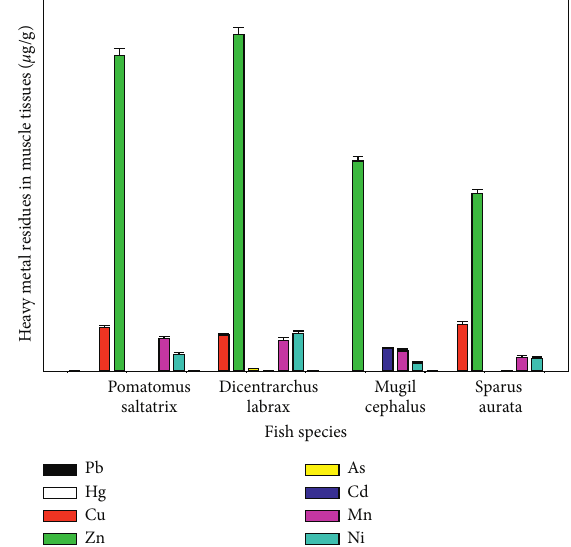
Figure 9: Concentration of Pb, Hg, Cu, Zn, As, Cd, Mn, and Ni residues ( μ g/g) in muscle tissues of fish samples from Duzce, Cost of Black